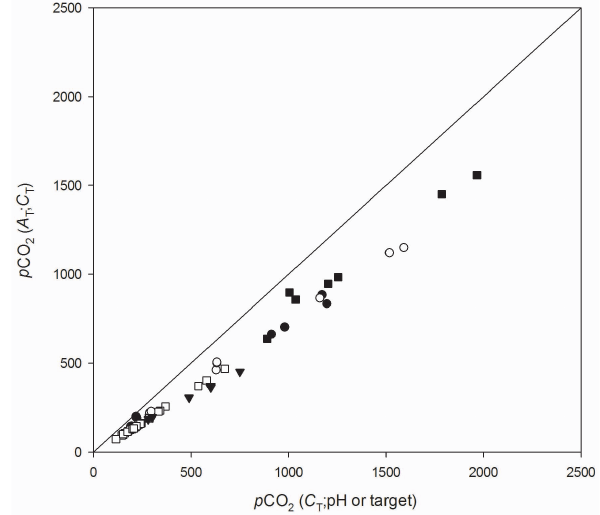
Fig. 1. Calculated p CO 2 ( A T ; C T ) versus calculated p CO 2 ( C T ; pH) inµatm from this study (closed circles, natural seawater; open circles, artificial seawater), Schneider and Erez, 2006 (open squares), Thomsen et al., 2010 (closed squares) and Iglesias- Rodr´ıguez et al., 2008 (closed triangles; here p CO 2 (target) instead of p CO 2 (C T ; pH) is given). p CO 2 values were calculated for the respective salinity, nutrients and carbonate chemistry parameters at 15 ◦ C for all